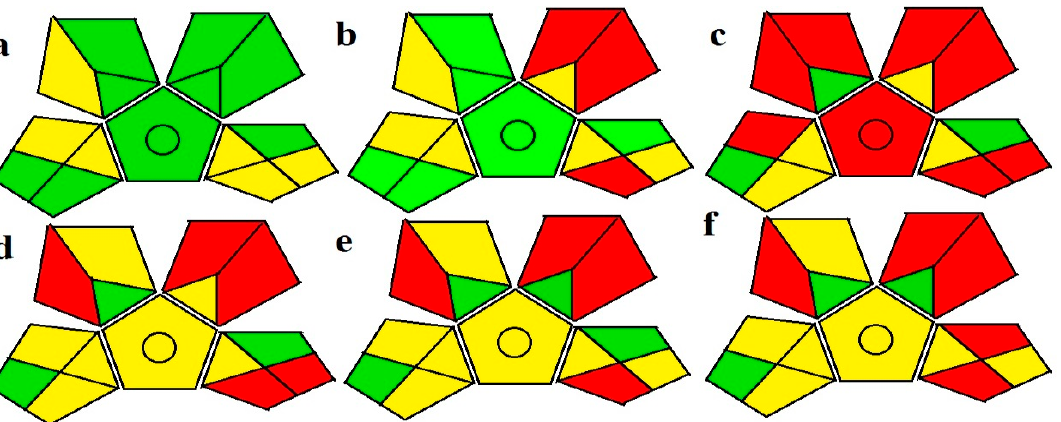
Figure 2. The GAPI pictograms for ( a ) the proposed green HPLC method, ( b ) the conventional HPLC proposed method and previously reported methods, ( c ) for method [9], ( d ) for method [14], ( e ) for method [17], and ( f ) for method [23]. The red zones reveal high ecological impact, yellow zones reveal lower impact, and green zones reveal safe effect to environment.